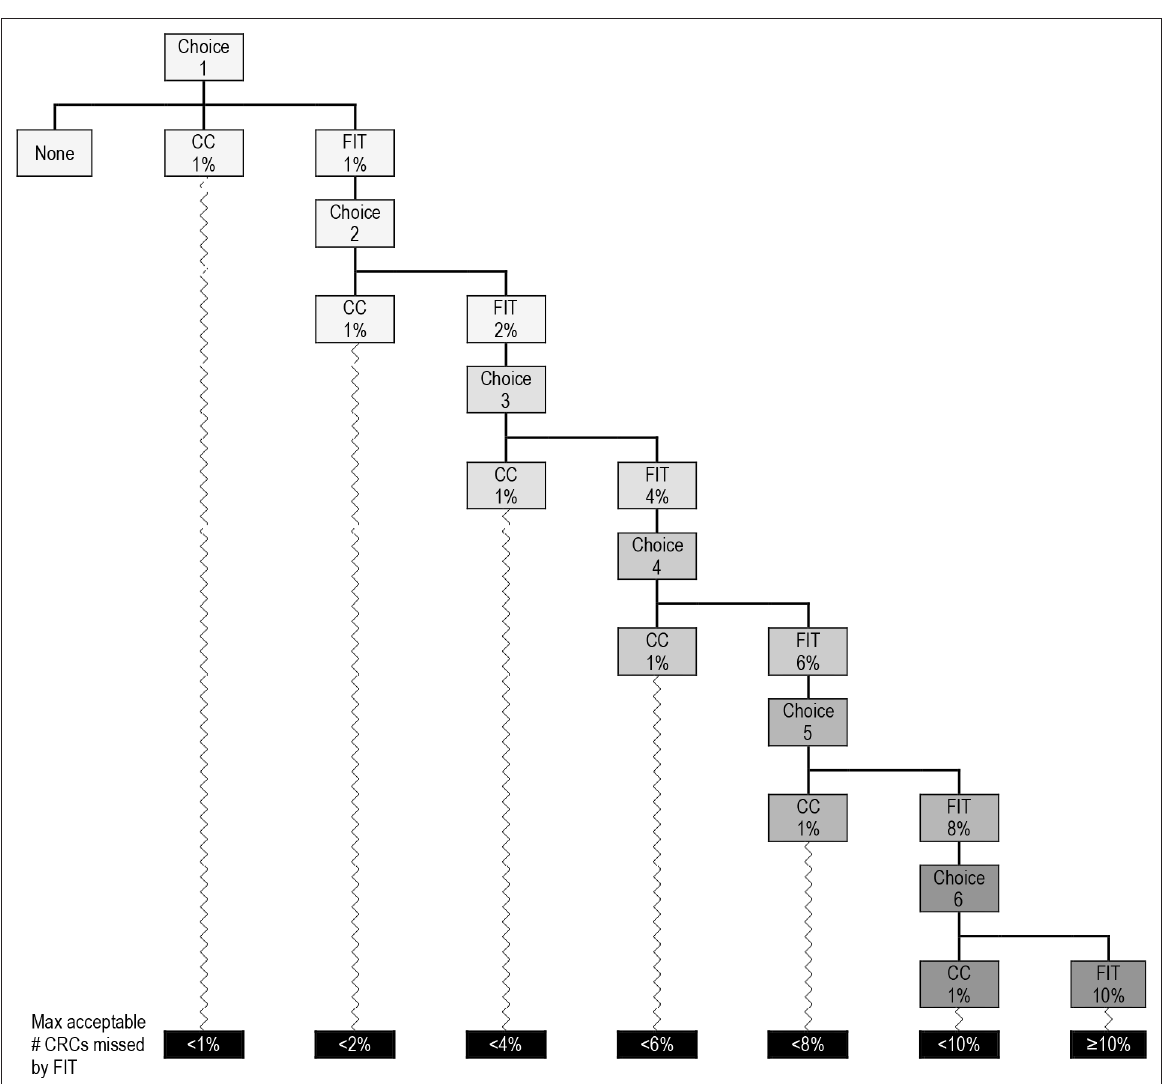
Figure 2 Dynamic forced‑ choice staircases CC = colonoscopy. CRC = colorectal cancer. FIT = faecal immunochemical test. Max =